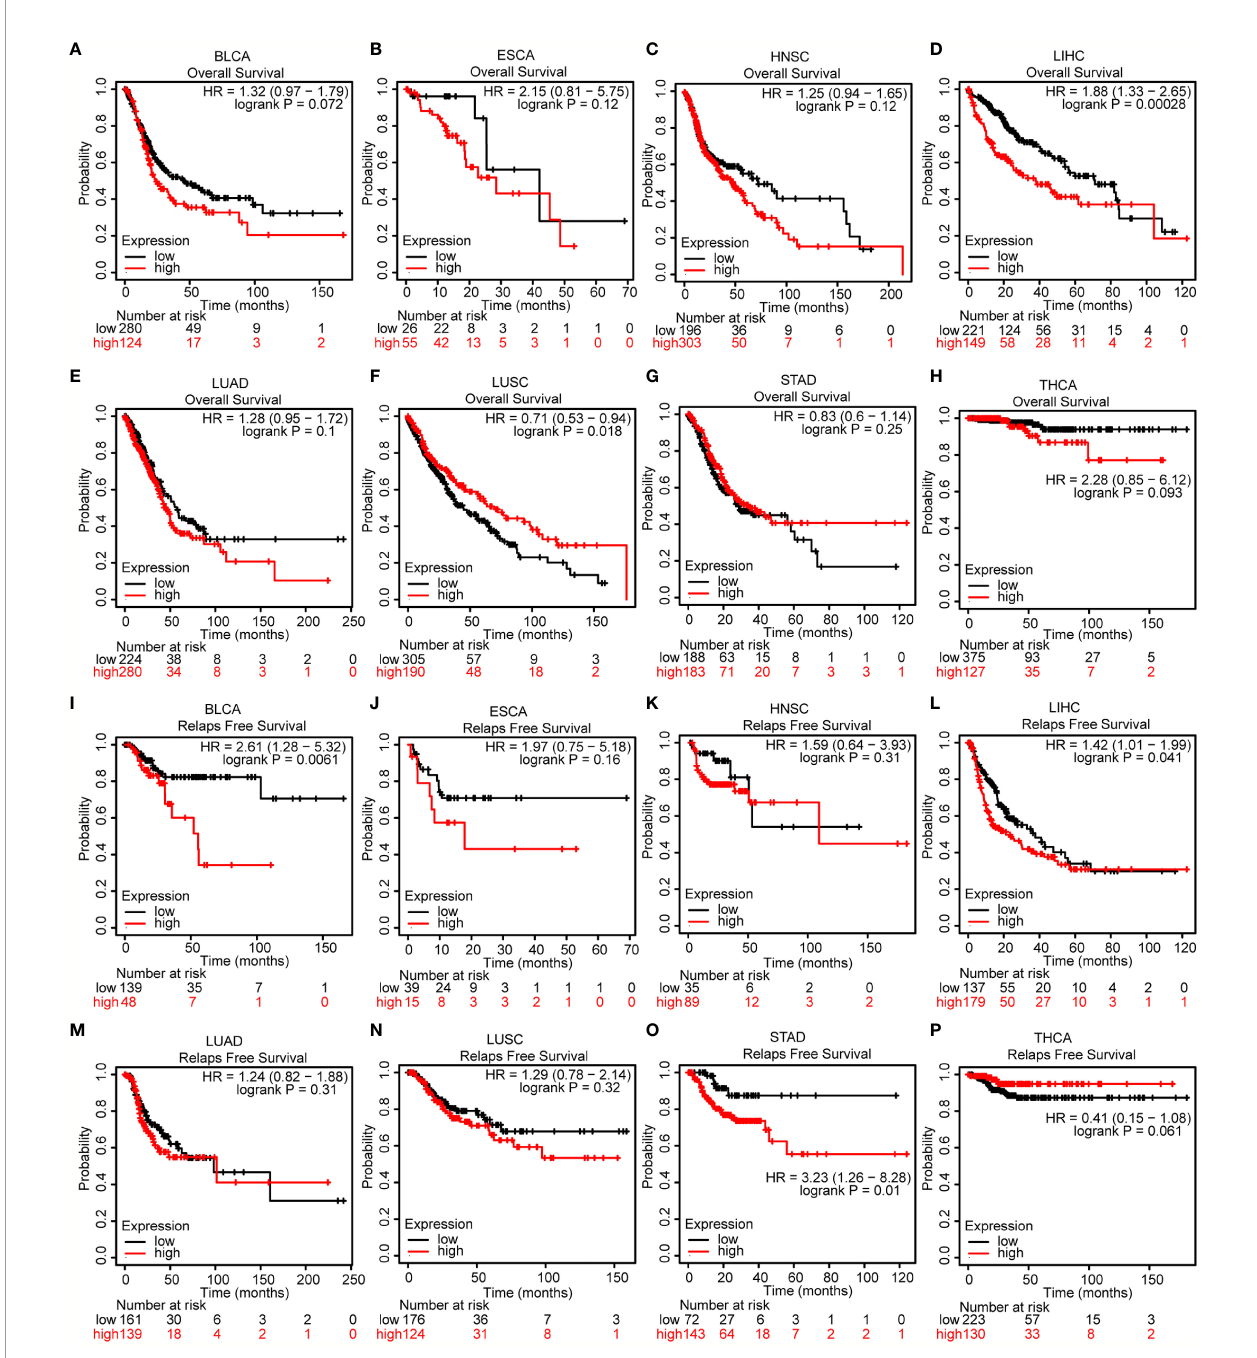
FIGURE 2 | Prognostic value of COMMD2 in various human cancers. (A – H) Overall survival (OS) analysis of COMMD2 in BLCA (A) , ESCA (B) , HNSC (C) , LIHC (D) , LUAD (E) , LUSC (F) , STAD (G) and THCA (H) . (I – P) Relapse-free survival (RFS) analysis of COMMD2 in BLCA (I) , ESCA (J) , HNSC (K) , LIHC (L) , LUAD (M) , LUSC (N) , STAD (O) and THCA (P)